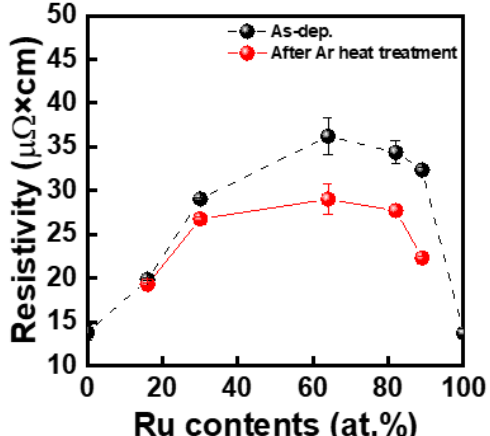
Figure 3. Electrical resistivity of PtRu bimetallic alloy thin films according to the film compositions before and after Ar heat treatment at 700 °C.